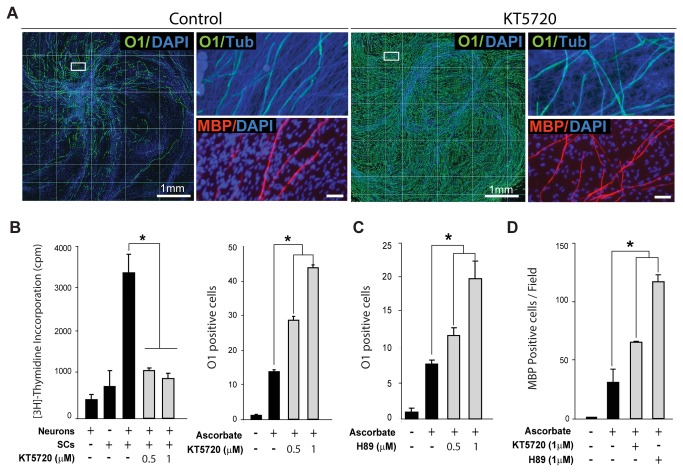
Effect of PKA inhibitors on axon contact-dependent SC proliferation and myelin sheath formation in SC-neuron cultures.SCs in co-culture with DRG neurons were induced to form myelin by addition of ascorbate-containing medium provided alone (control) or together with KT5720 or H89. Cultures were fixed 12 days after ascorbate addition (myelination phase) and analyzed by immunofluorescence microscopy (Methods). In B (left panel), SCs were seeded as a single cell suspension directly onto cultures of purified DRG neurons in the absence (control) or presence of KT5720, as indicated, and allowed to incorporate [3H]-thymidine for 3 days before analysis by scintillation counting. In A, myelinating SCs were identified by double immunostaining with O1 (green) and MBP (red) antibodies. MBP expression is a reliable indicator of the onset and progression of myelination in this co-culture system. The integrity of the DRG axons was confirmed by immunostaining with axon-specific βIII-tubulin antibodies (Tub, blue) and nuclei were identified with DAPI (blue). In this and all subsequent figures containing results derived from myelination assays, a composite of 10x magnification fields is shown to emphasize the relative distribution of myelinating SCs throughout the culture area (A, left panels). Ascorbate typically induces the appearance of O1 positive, MBP positive (myelinating) cells in a fraction of the SC population that is usually restricted to the area adjacent to the neuronal bodies. Selected areas (A, right panels) are shown at a higher resolution to reveal features of the myelinating cells, such as morphology and MBP expression, that cannot be appreciated at lower magnifications. Quantitative analysis of the density of O1 positive (B-C) and MBP positive cells (D) was done by automated image analysis and manual counting, respectively. In B-C, data is represented as the number of fields containing more than fifty O1 positive SCs (out of 150 microscopic fields), as we found that this measure provides a more reliable representation of the relative changes in myelination over large culture surfaces.